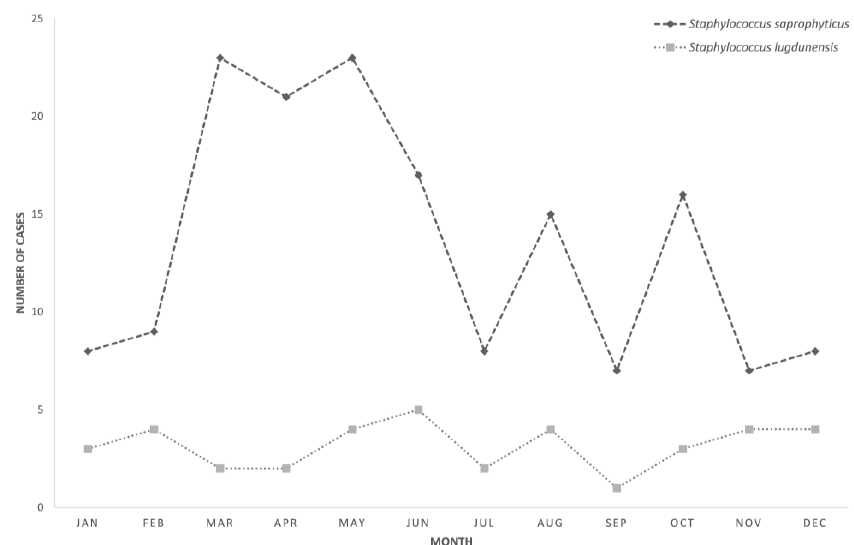
Figure 3. Cases of S. saprophyticus - and S. lugdunensis -associated urinary tract infection recorded by month of specimen collection (2009 – 2018).